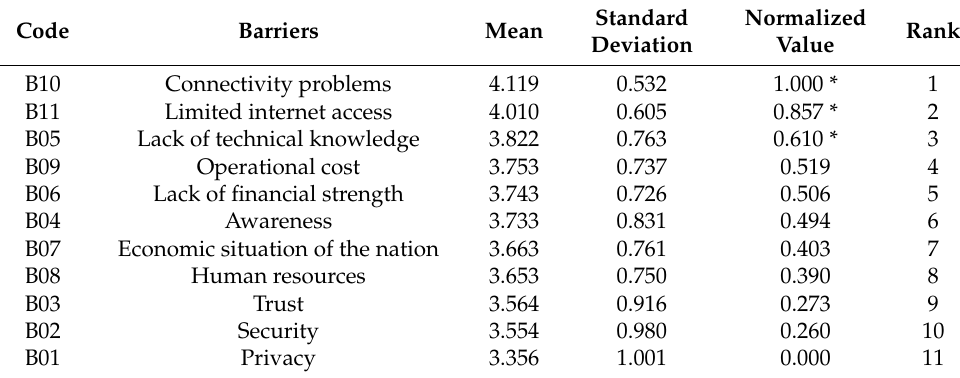
Table 3. Results for the mean ranking and normalization